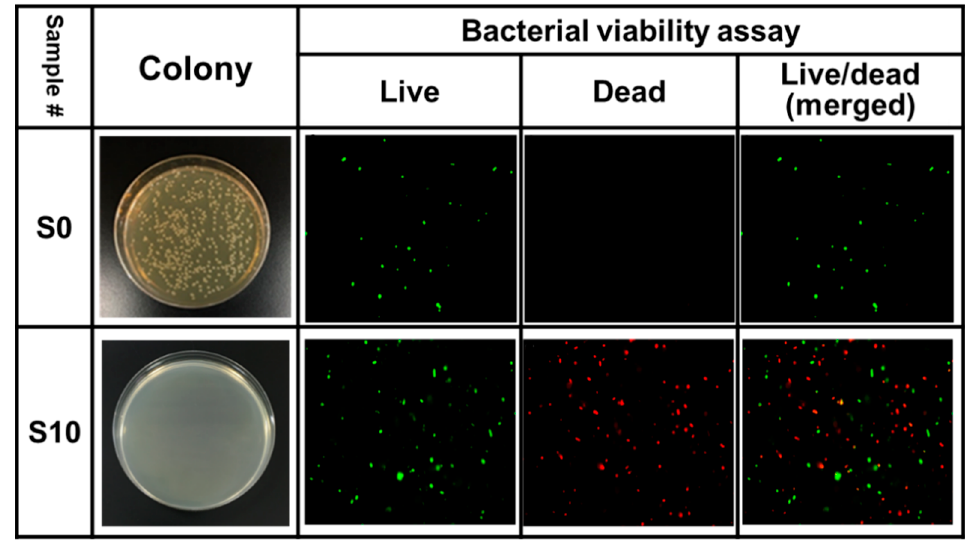
Figure 6. S10 CAPJ induces bacterial death. Photos of bacterial colonies of control S0 and confirmation test of CAPJ treated under S10, fluorescence live/dead bacterial viability assay images of E. coli without CAPJ (S0) and with CAPJ treated under S10.